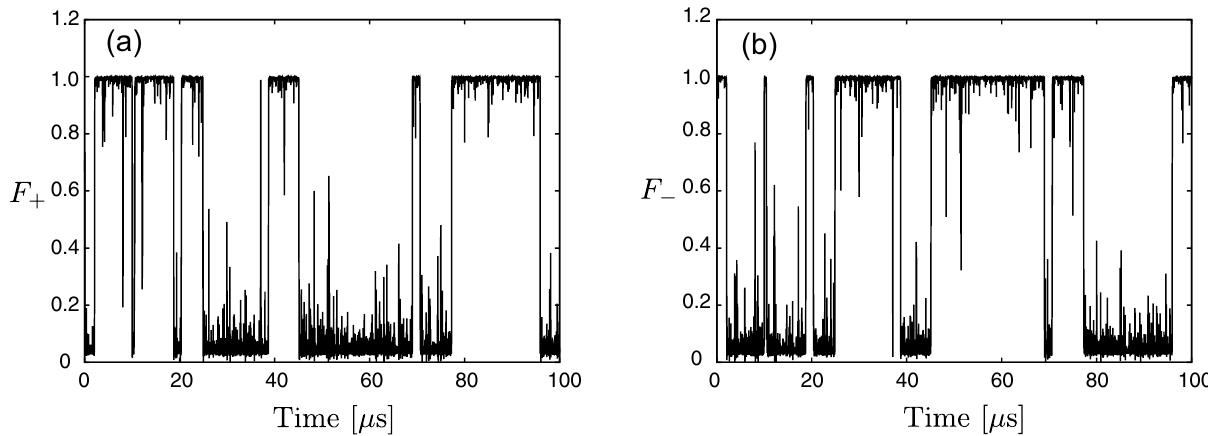
F ρ c ( t ) , α α . Panels ( a ) and ( b ) are for F |± ��± |] [ ± = 3 MHz , β/ 2 π 3 MHz and κ/ 2 π 3 MHz . α given by Eq. (2) = = =